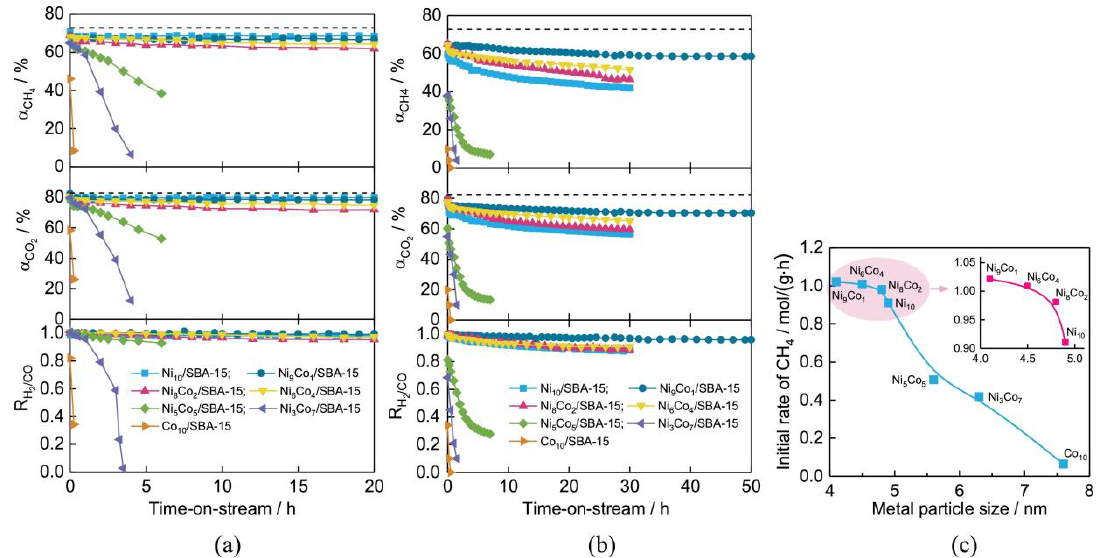
Figure 7. Catalytic activity of various Ni x Co 1−x /SBA-15 catalysts at 973 K and ( a ) GHSV = 36,000 mL/g/h and ( b , c ) 72,000 mL/g/h. Reproduced with permission from [58].